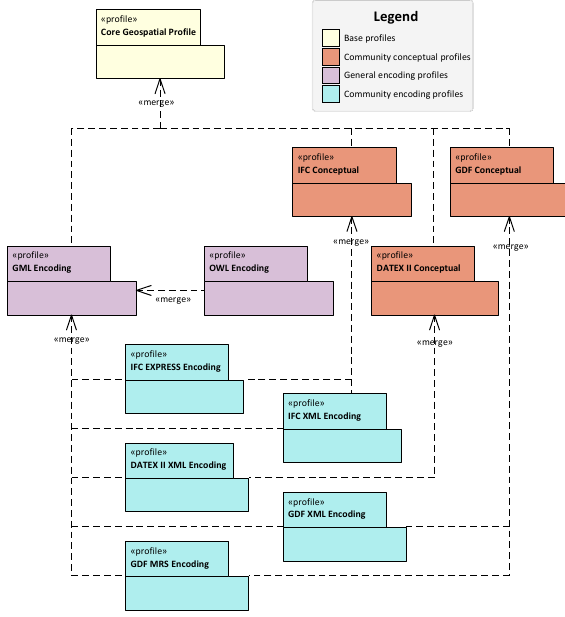
Figure 6. Structure of UML Profiles.